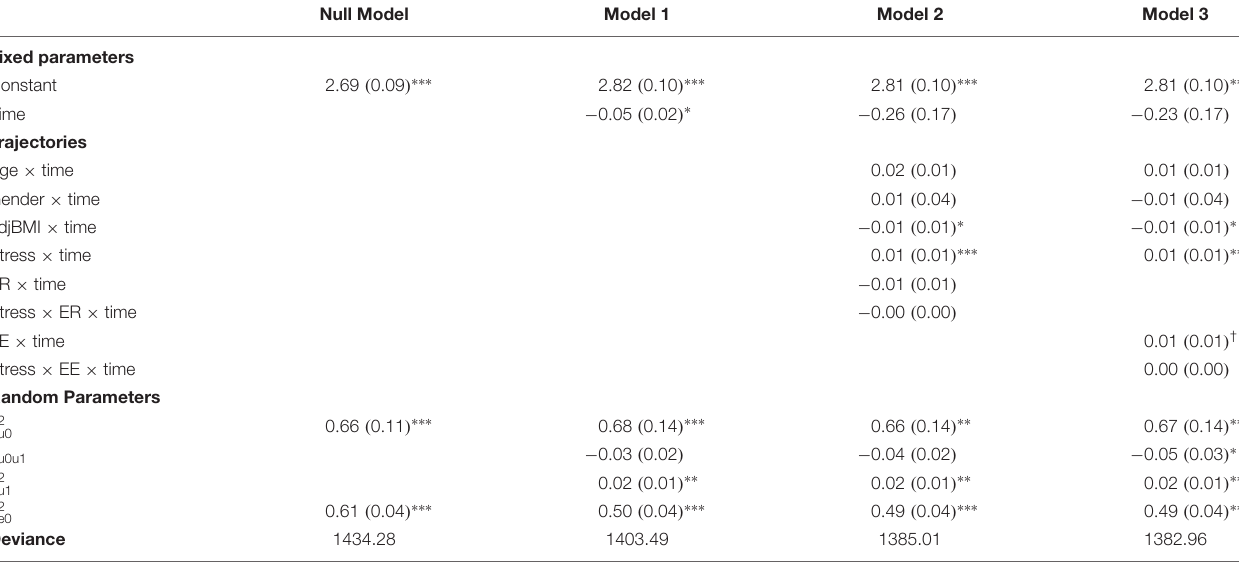
TABLE 3 | Daily desire to eat as a function of stress, maladaptive emotion regulation, and trait emotional eating.